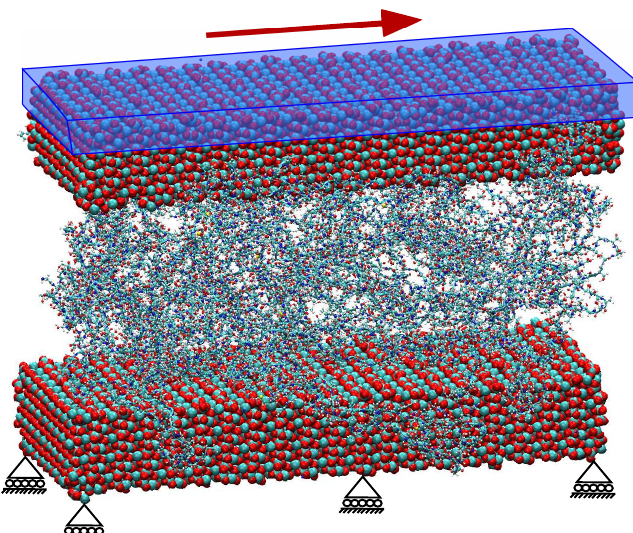
Figure 1. Schematic representation of shearing of the organic matrix. Bottom tablet of aragonite is constrained in all directions, and velocity (red arrow) is applied on the upper surface of the top tablet (blue